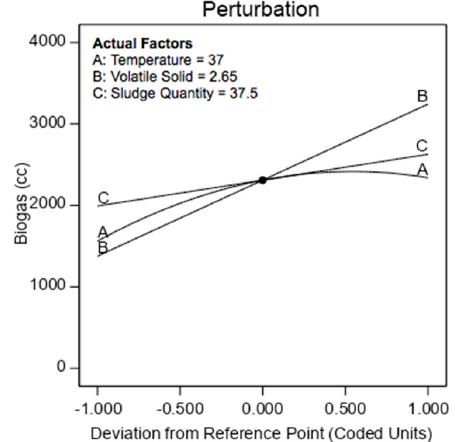
Energies 2020 , 13 , x; doi: FOR PEER REVIEW Figure 4. Perturbation plot shows the effect of all factors on the biogas volume. Figure 4. Perturbation plot shows the e ff ect of all factors on the biogas volume.